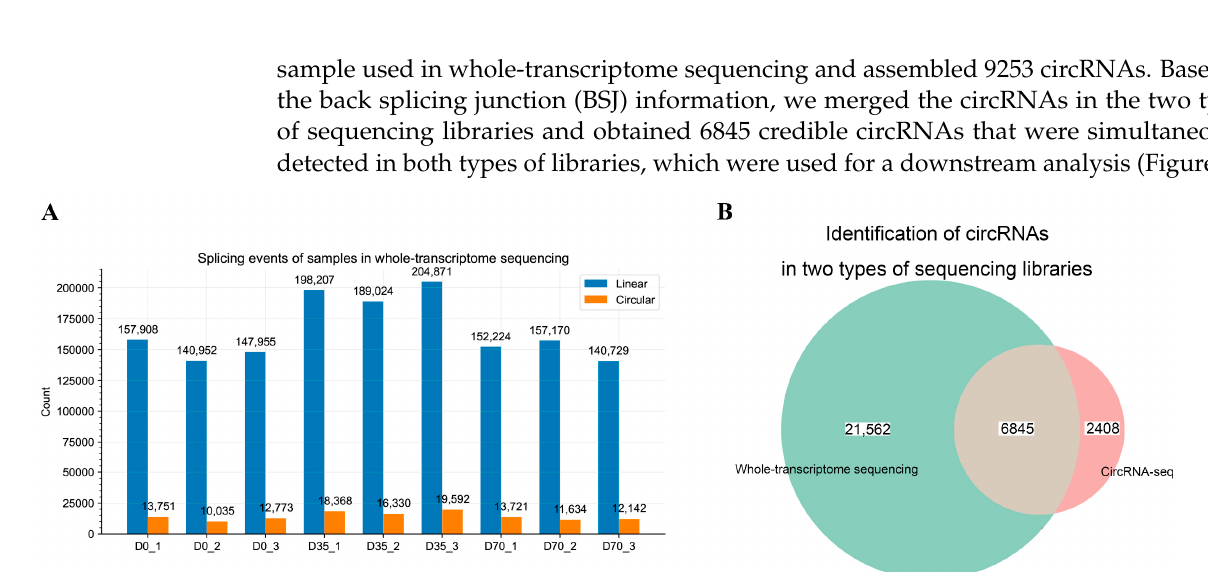
Figure 3. Characterization of circRNAs in skeletal muscle tissues. ( A ) Genomic distribution of circR- NAs. ( B ) The number of circRNAs with different exon counts. ( C ) The length distribution of circR- NAs. ( D ) Venn diagram of the expressed circRNAs in D0, D35, and D70. ( E ) The number of con- served circRNAs between rabbits and mice, and between rabbits and humans. 3.3. Differential Analysis of circRNAs during Skeletal Muscle Development in Rabbits Hierarchical clustering based on the CPM values sorted nine samples into three dis- tinct clusters corresponding to D0, D35, and D70, indicating the excellent reproducibility of our whole-transcriptome sequencing data (Figure 4A). To understand the regulation of circRNAs in skeletal muscle development, we performed a differential analysis. Our re- sults showed that 176 and 420 circRNAs were significantly downregulated and upregu- lated from D0 to D35, respectively (Figure 4B). On the other hand, 281 and 138 circRNAs were significantly downregulated and upregulated from D35 to D70, respectively (Figure 4C). The Venn diagrams constructed using differentially expressed circRNAs (DECs) showed no overlap between the upregulated circRNAs from D0 to D35 and the upregu- lated circRNAs from D35 to D70, and no overlap between the downregulated circRNAs from D0 to D35 and the downregulated circRNAs from D35 to D70. On the other hand, 85 downregulated circRNAs from D0 to D35 were upregulated from D35 to D70, and 212 upregulated circRNAs from D0 to D35 were downregulated from D35 to D70 (Figure 4D).